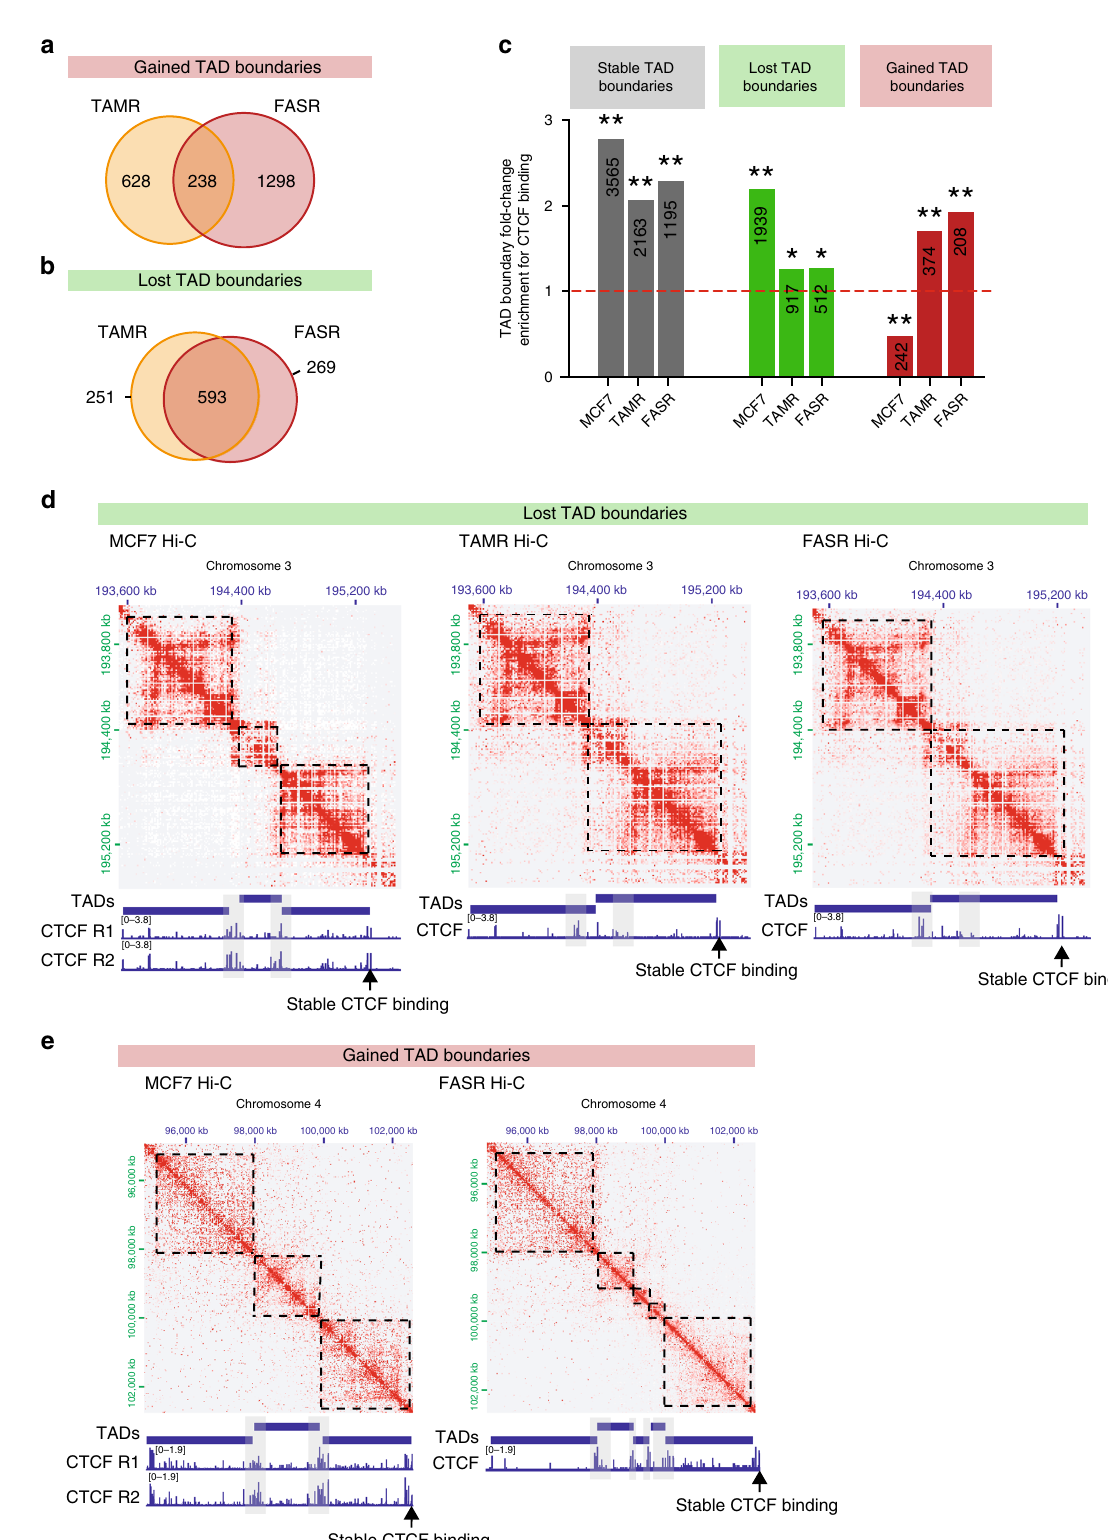
modi fi cations H3K4me3, H3K4me1 and H3K27ac and B-type compartments showing enrichment for “ repressive ” histone mark H3K27me3 in all three cell types (Fig. 6a and Supplementary Fig. 6b). Additionally, TADs identi fi ed in each of the cell types were mainly located within the compartment regions (68.21% in MCF7, 68% in TAMR and 60.65% in FASR) with most of